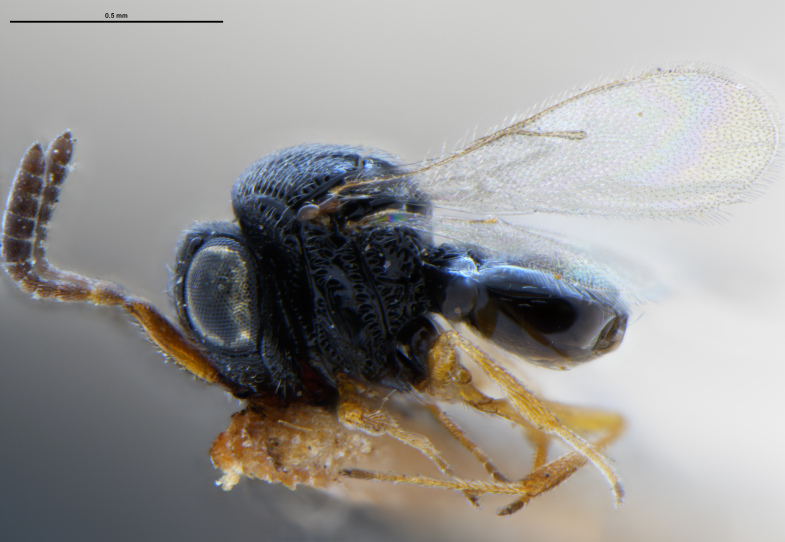
lateral habitus